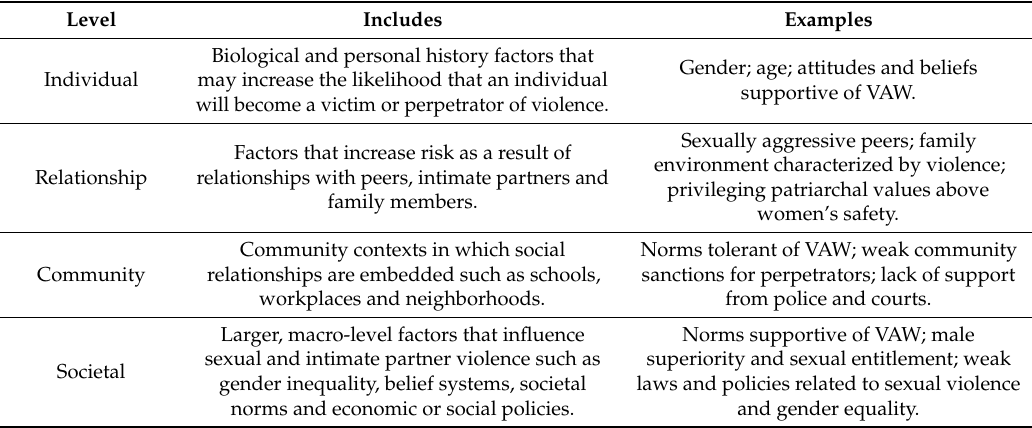
Table 1. Levels (ecologies) of violence against women